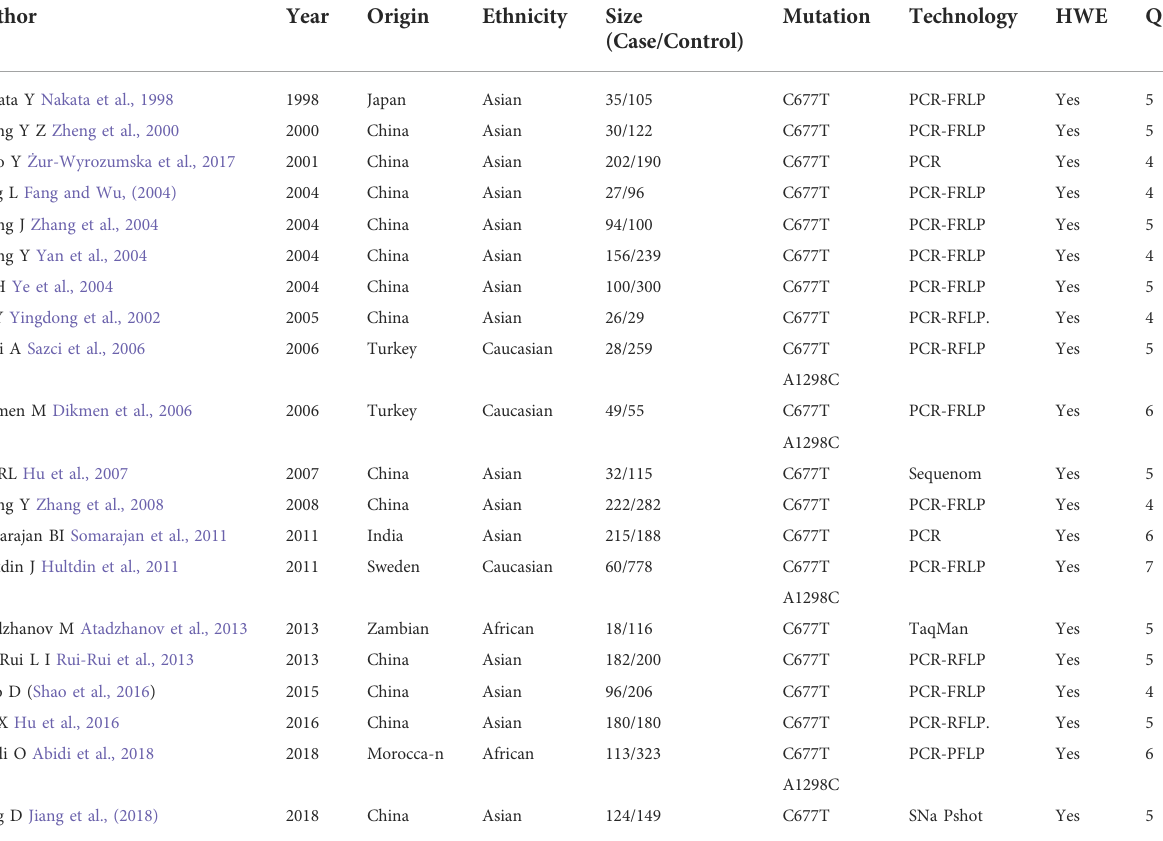
TABLE 1 The characteristics of all studies in the meta-analysis of the association between MTHFR gene C677T and A1298C polymorphisms with the risk of intracerebral hemorrhage. PCR-RFLP = Polymerase Chain Reaction-Restriction Fragment Length Polymorphism. SNP = Single Nucleotide Polymorphism. HWE = Hardy Weinberg Equilibrium. QS = Quality score.